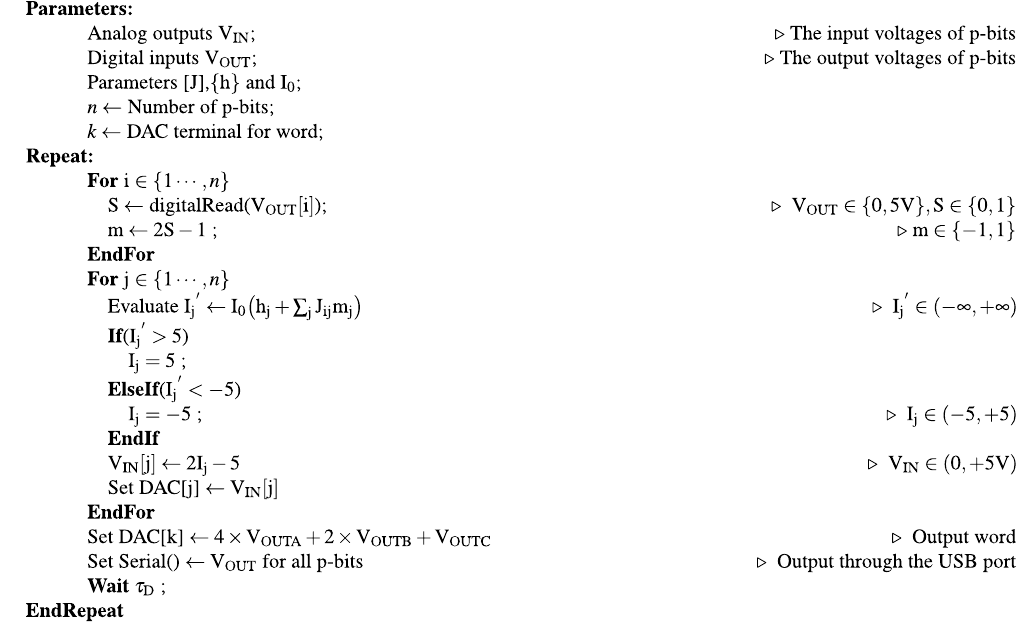
Algorithm 2. Pseudo code for weight